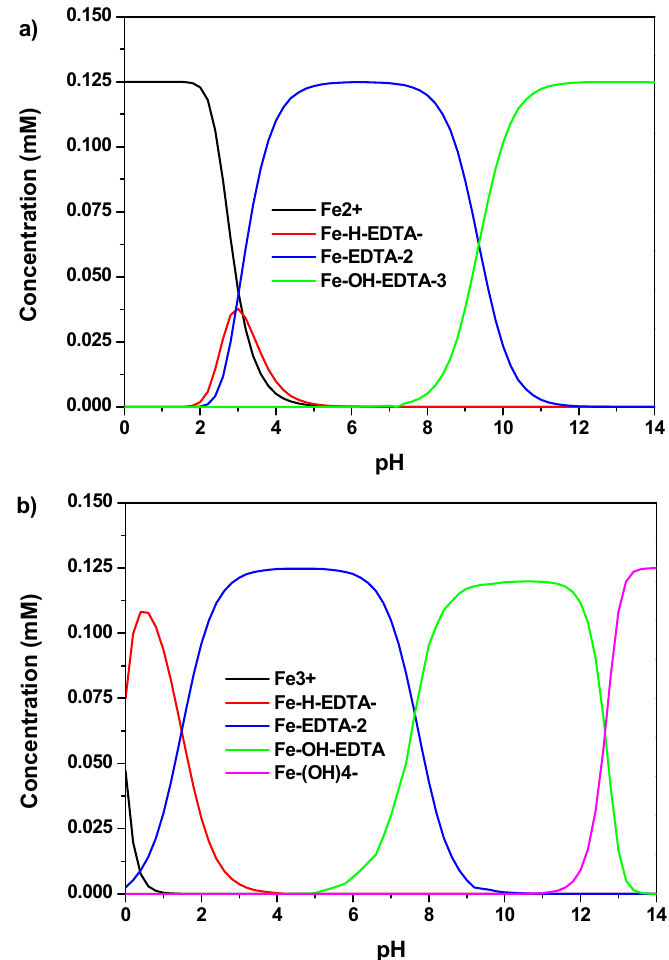
Figure 2. Equilibrium distribution of [Fe-EDTA] species as a function of pH for ( a ) Fe 2+ and ( b ) Fe 3+ , assuming 0.125 mM concentration of Fe and EDTA [40].